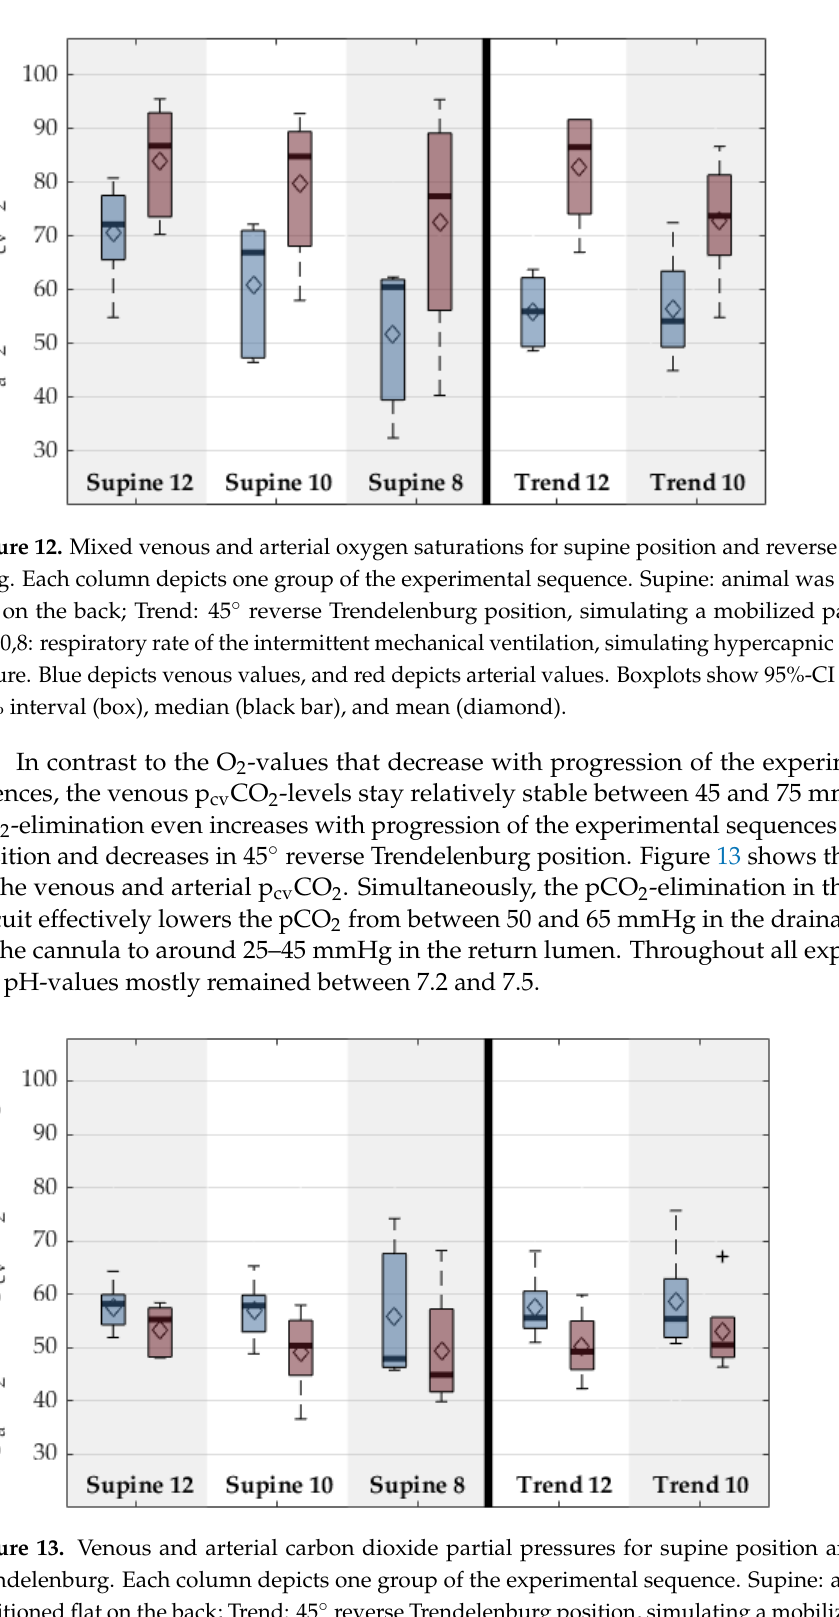
Figure 13. Venous and arterial carbon dioxide partial pressures for supine position and reverse Trendelenburg. Each column depicts one group of the experimental sequence. Supine: animal was positioned flat on the back; Trend: 45° reverse Trendelenburg position, simulating a mobilized patient; and 12,10,8: respiratory rate of the intermittent mechanical ventilation, simulating hypercapnic respiratory failure. Blue depicts venous values in the vena cava, and red depicts arterial values. Boxplots show 95%-CI (whiskers), 50%-interval (box), median (black bar), mean (diamond), and outlier (black cross).